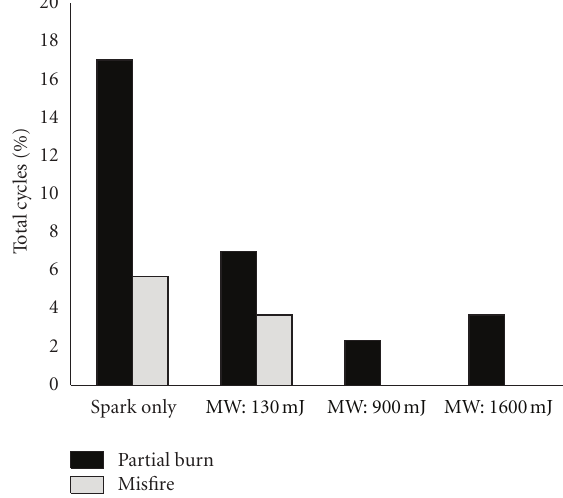
Figure 2: Engine stability increases with the addition of microwave energy as λ increases. Increasing microwave energy from 900 mJ to 1600 mJ did not further increase engine stability.